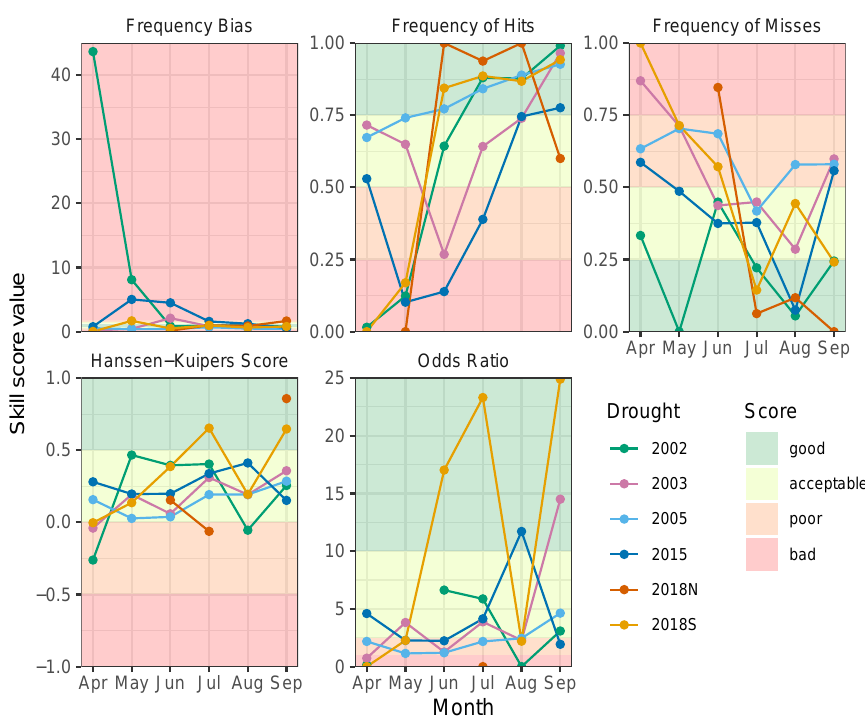
Figure 6. Skill scores for the soil moisture drought as a proxy for vegetation drought. The background colours indicate the quality of the skill scores (see Methods for their description), and the lines show different drought